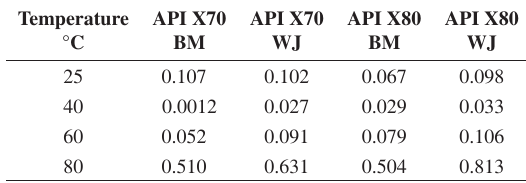
Table 4. Corrosion rates in mm/year, vapor phase.